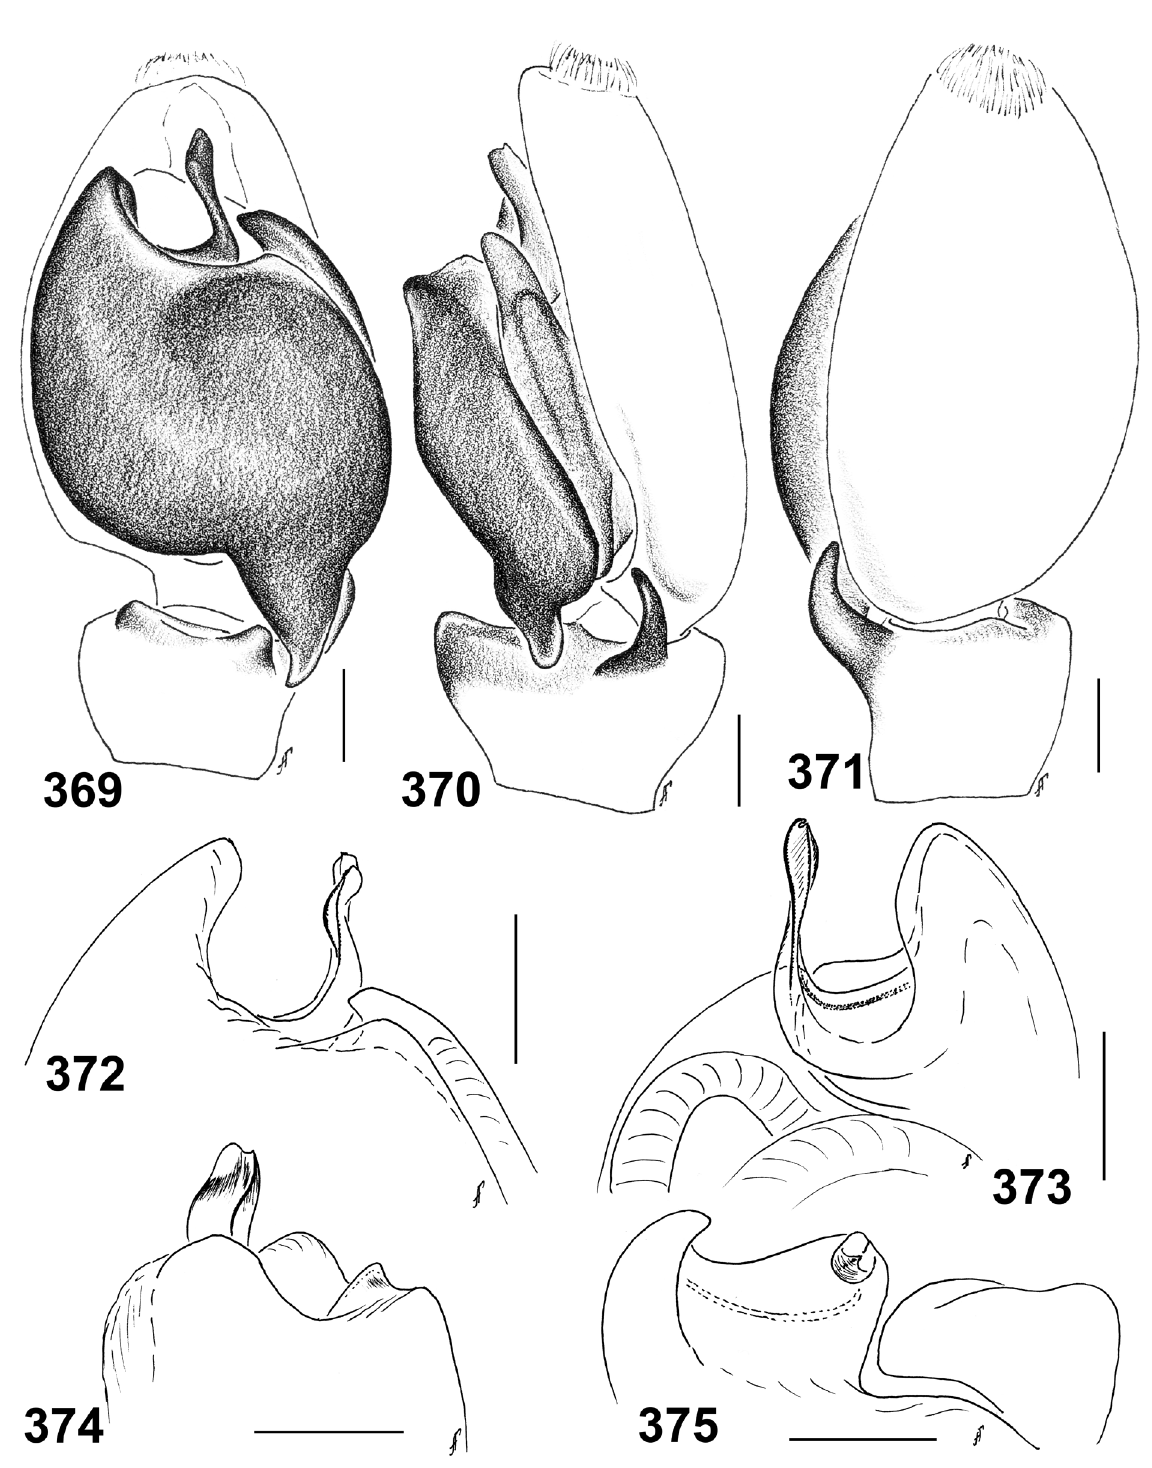
Figs 369–375. Stenaelurillus nigricaudus Simon, 1886, from Senegal (Richard Toll). 369–371 . Male palp. 369 . Ventral view. 370 . Retrolateral view. 371 . Dorsal view. 372–375 . Embolic division. 372 . Ventro- apical view. 373 . Dorsal view. 374 . Median view. 375 . Apical view. Scale bars: